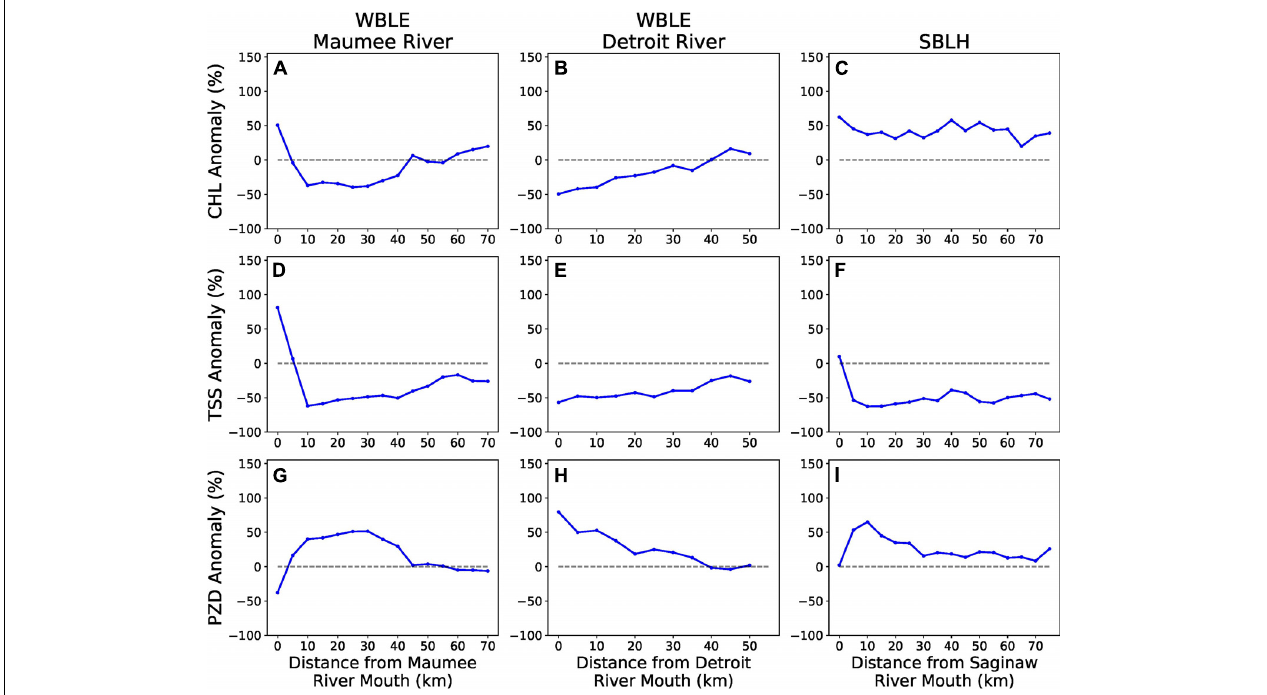
FIGURE 5 | Median April anomaly value is plotted based on distance from the nearest major river mouth (Maumee and Detroit Rivers for WBLE; Saginaw River for SBLH). The distances are binned in 5-km increments. (A,D,G) The average CHL, TSS, and PZD anomalies in WBLE based on distance from the Maumee River. (B,E,H) The average CHL, TSS, and PZD anomalies in WBLE based on distance from the Detroit River. (C,F,I) The average CHL, TSS, and PZD anomalies in SBLH based on distance from the Saginaw